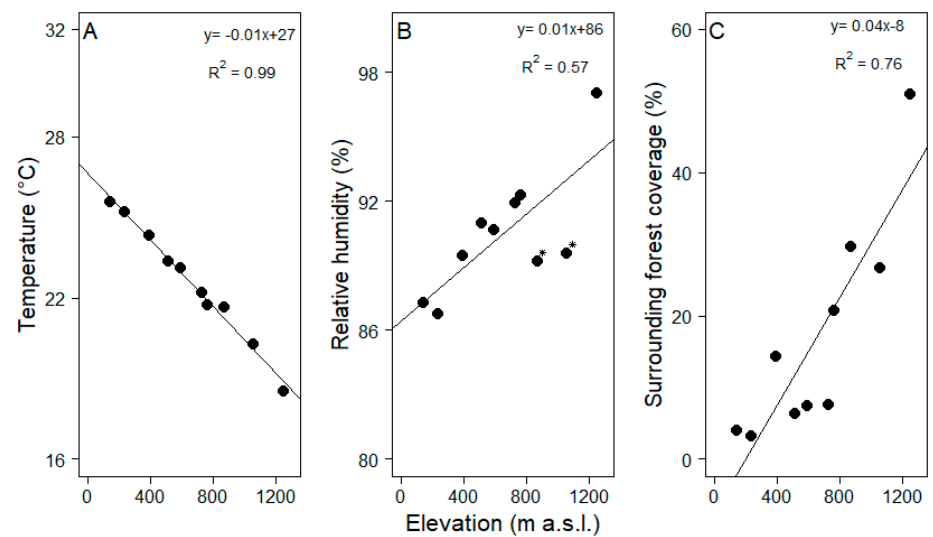
Figure 2. Changes in abiotic and biotic features that might influence epiphyte assemblages (( A )